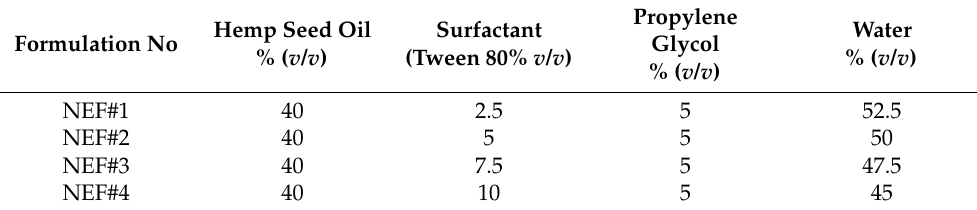
Table 3. Composition of hemp seed oil nanoemulsion formulations.